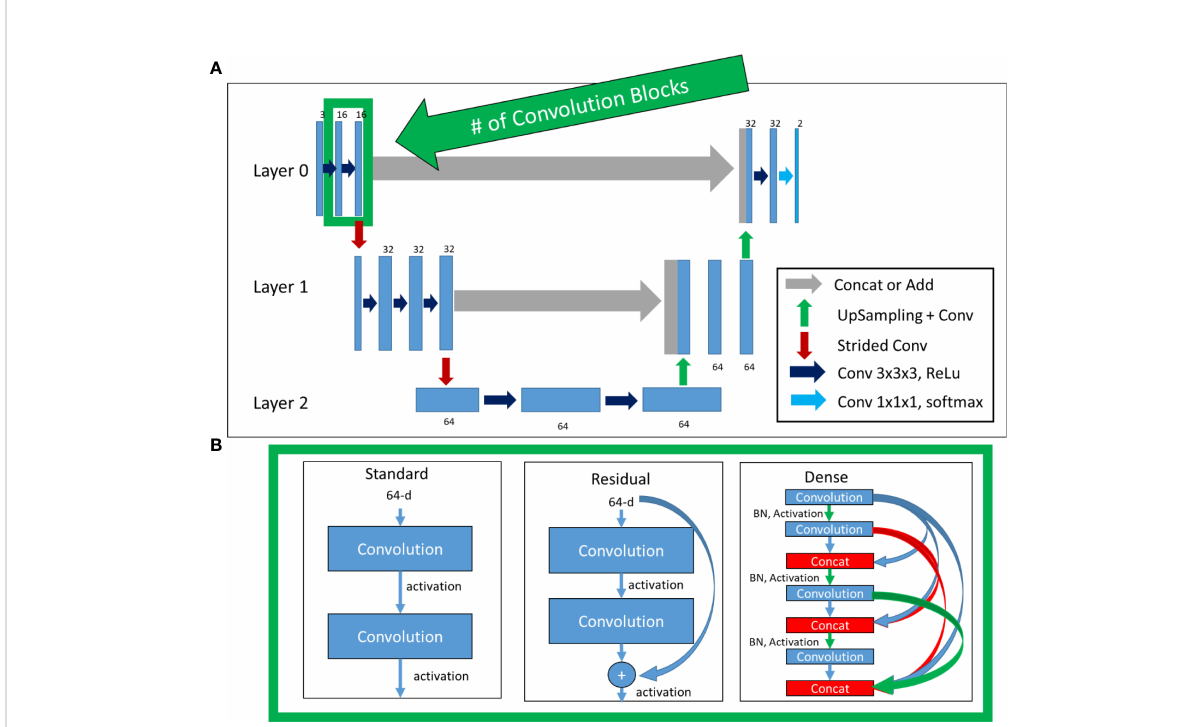
FIGURE 2 Top (A) : Basic architecture framework. Bottom (B) : Difference in convolution blocks, surrounded by green to indicate the same region in (A) . Standard: previous feature maps are convolved and activated. Residual: previous feature maps are directly added to convolutional output in a skip-connection before activation. Dense: previous feature maps are continually concatenated together before activation and convolution. BN, batch